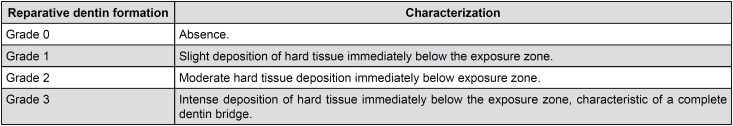
Classification of reparative dentin formation